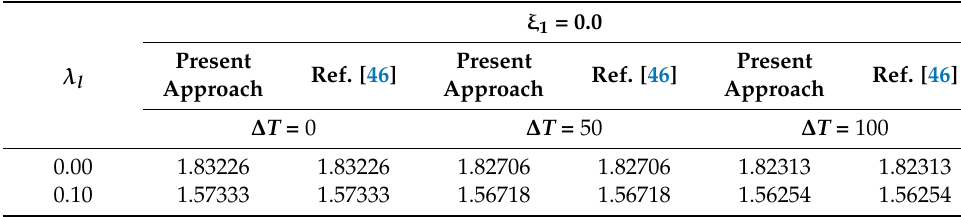
Table 3. Linear dimensionless natural frequencies of porous FG clamped–clamped (C–C) nano-beam ( A w = 0, λ c = 0.20, ξ 1 = 0.0).